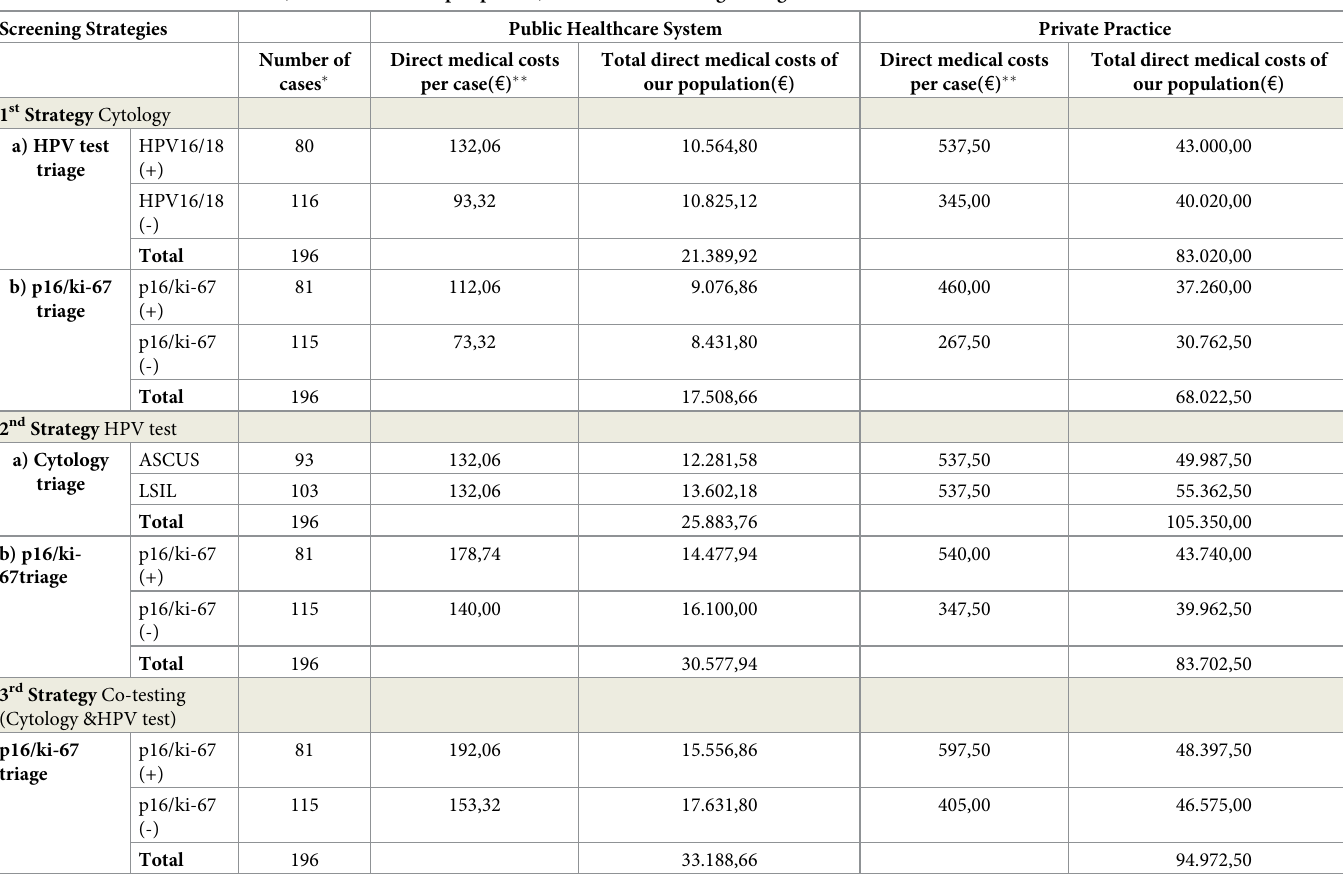
Cases in our population. Clinical data derived from Table 4. �� Direct medical costs of the procedures per woman screened. Data for calculations derived from Table